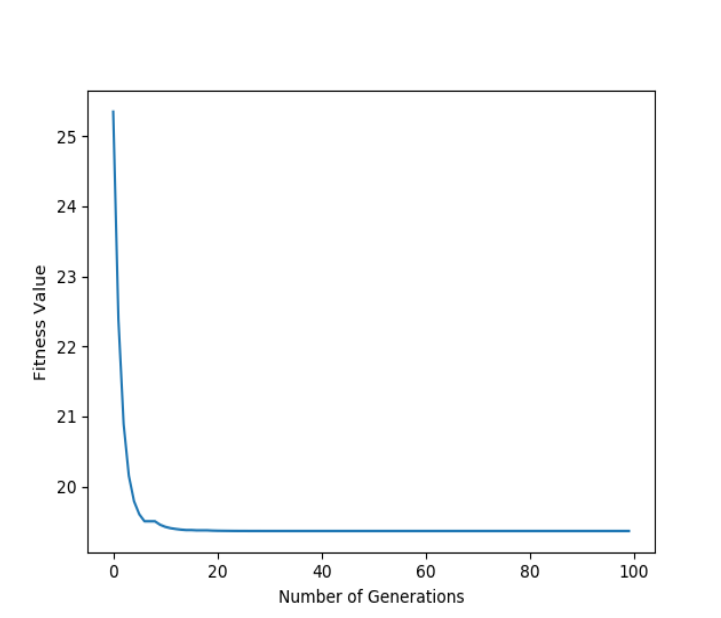
Figure 5. Convergence graph for image-20.